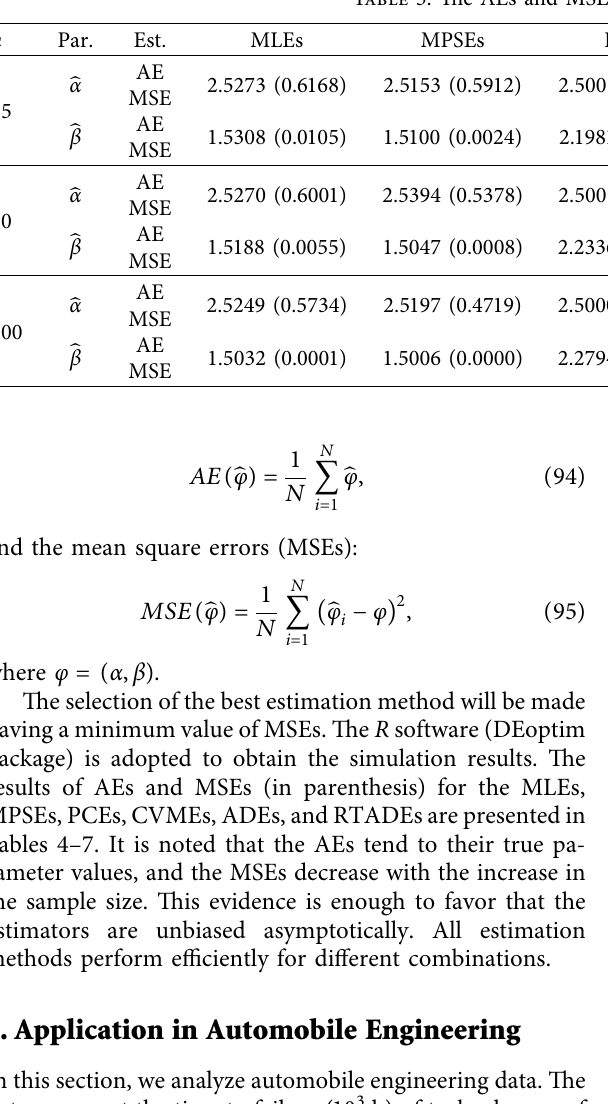
Table 5: The AEs and MSEs for ( α � 2 . 5 and β � 1 . 5 ) T